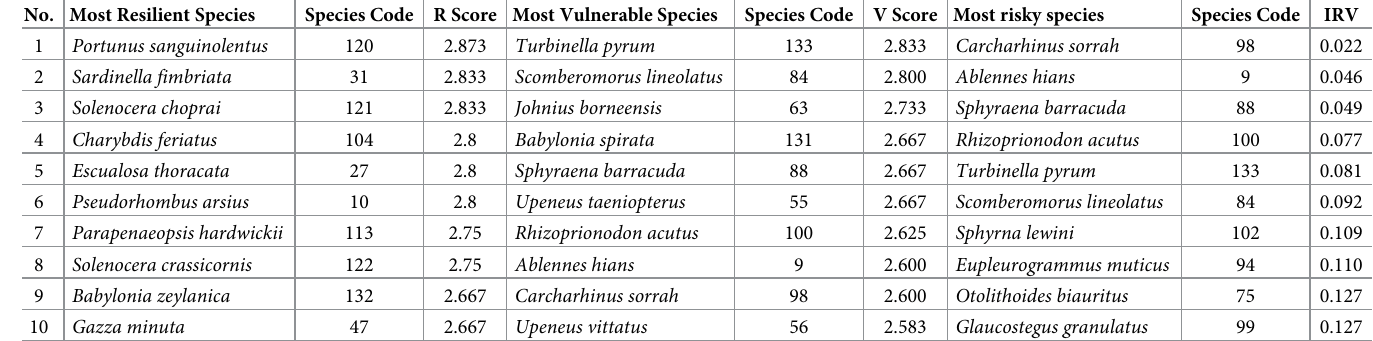
Table 3. Top 10 resilient and vulnerable species based on R and V scores; species code is provided to locate the position of the species in the IRV plot; species that scored low IRV have been designated as ‘risky’.